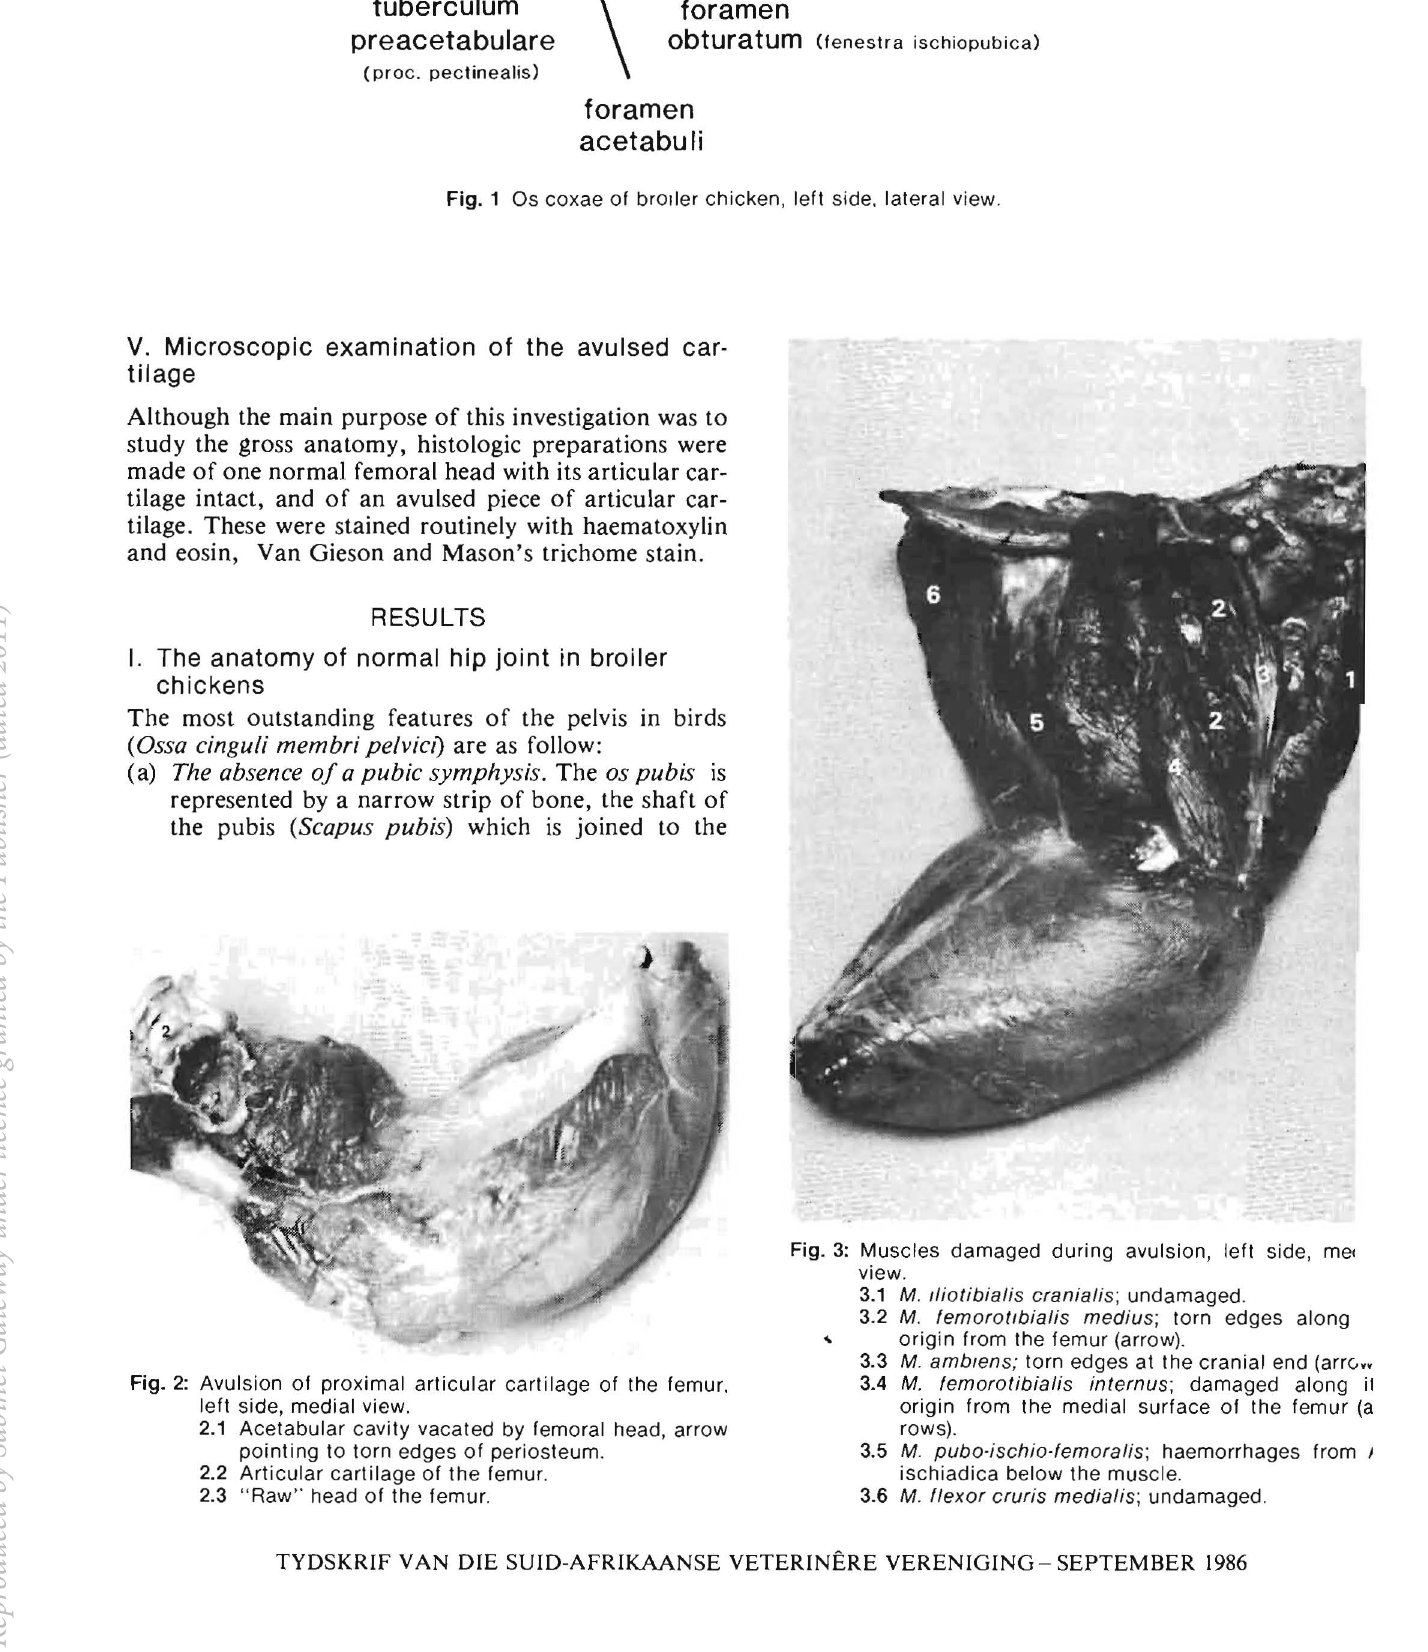
Fig. 1 Os coxae of brOiler chicken, left side. lateral view.